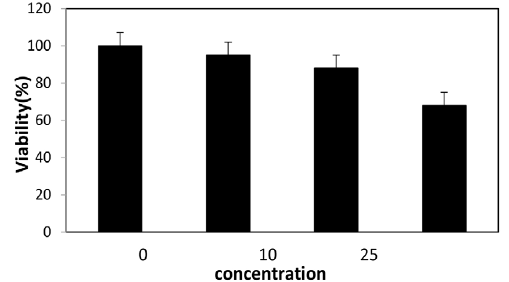
Fig. 9. Cytotoxic effects of different concentrations of B sample on MDA cells of Breast